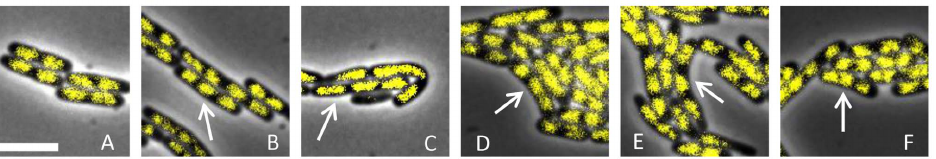
Figure 5. Merged phase contrast and YFP images of growing LT2 iscR :: yfp cells (previously grown overnight at 40–45 MPa and 37 6 C) after pressure release, showing (A) typical cells with a bilobed nucleoid, and (B–F) occasionally occurring cells with a ‘‘trilobed’’ nucleoid (indicated by arrows). Scale bar corresponds to 5 m m.